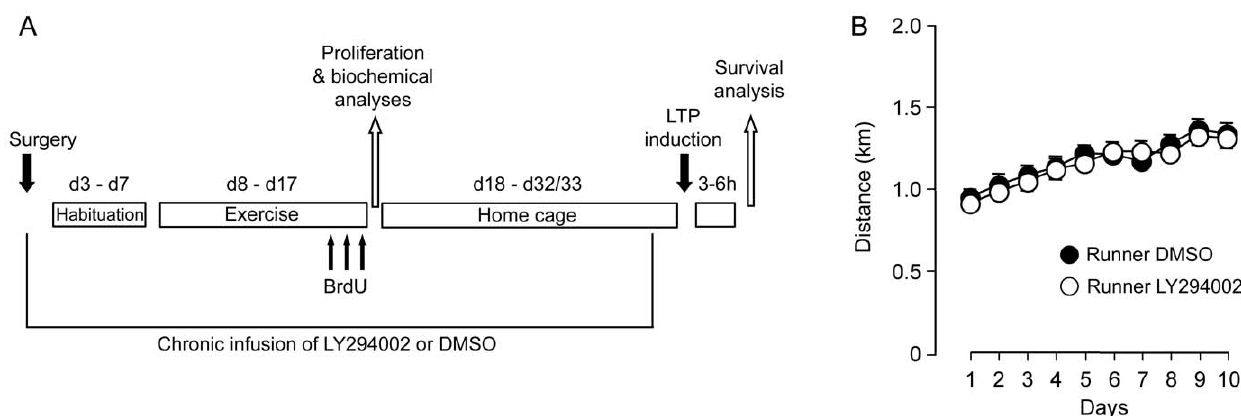
Figure 1. Experimental design and exercise performance. A, Schematic representation of the experimental protocol. B, Distance run in kilometres over the 10-day exercise period. Each point represents the combined distance covered each day for the two-hour session. Both groups started with the same number of kilometers (DMSO, black circles: DMSO: 0.94 6 0.05 km; LY294002, open circles: 0.89 6 0.05 km) and increased their distance run over the 10 days (DMSO: 1.34 6 0.07 km; LY294002: 1.31 6 0.06 km).